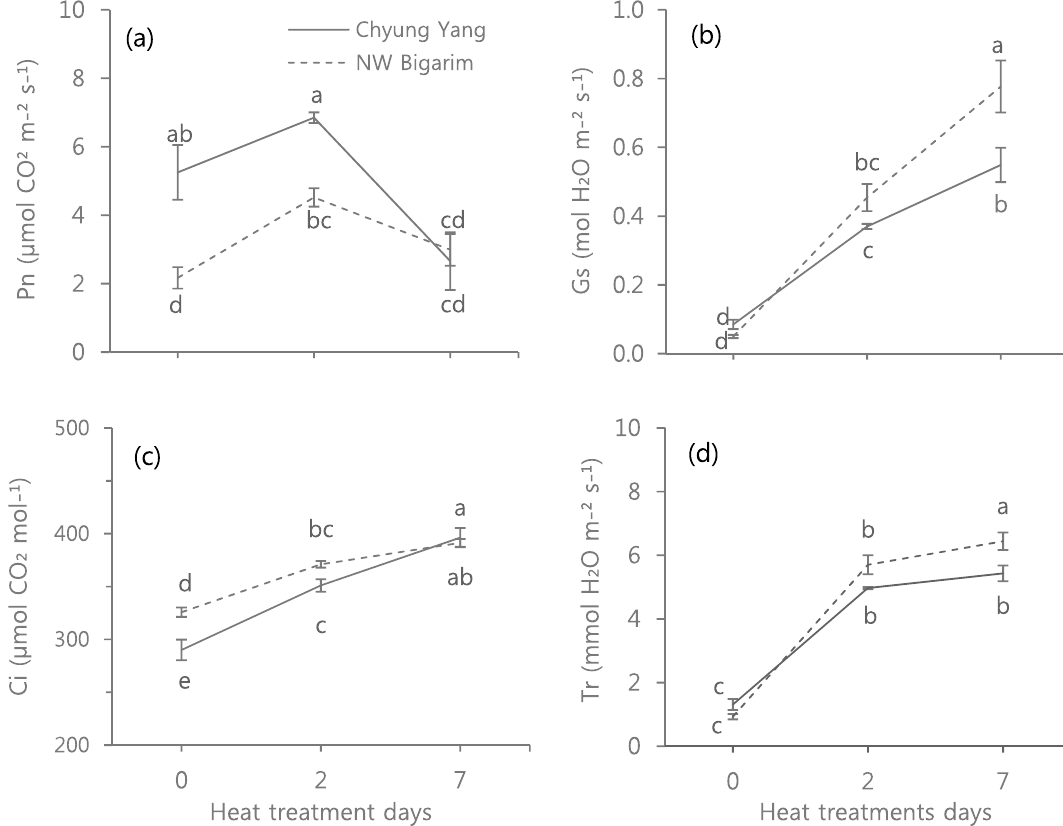
Figure 1. Effect of heat treatment of 42 °C on photosynthetic rate ( a ), stomatal conductivity ( b ), intercellular CO 2 concentration ( c ) and transpiration rate ( d ) of hot pepper seedlings. Vertical bars represent standard deviation (n = 3). Different letters indicate significant differences by Duncan’s multiple range test at p <